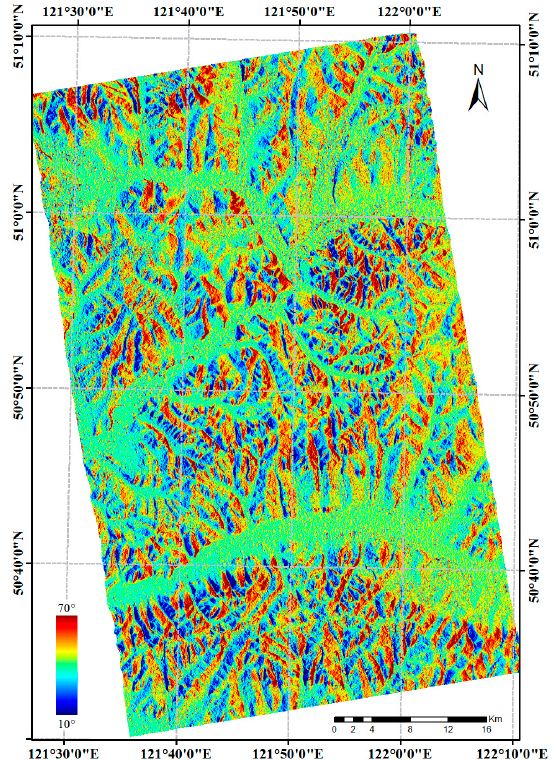
Figure 11. Local incidence angle θ loc .